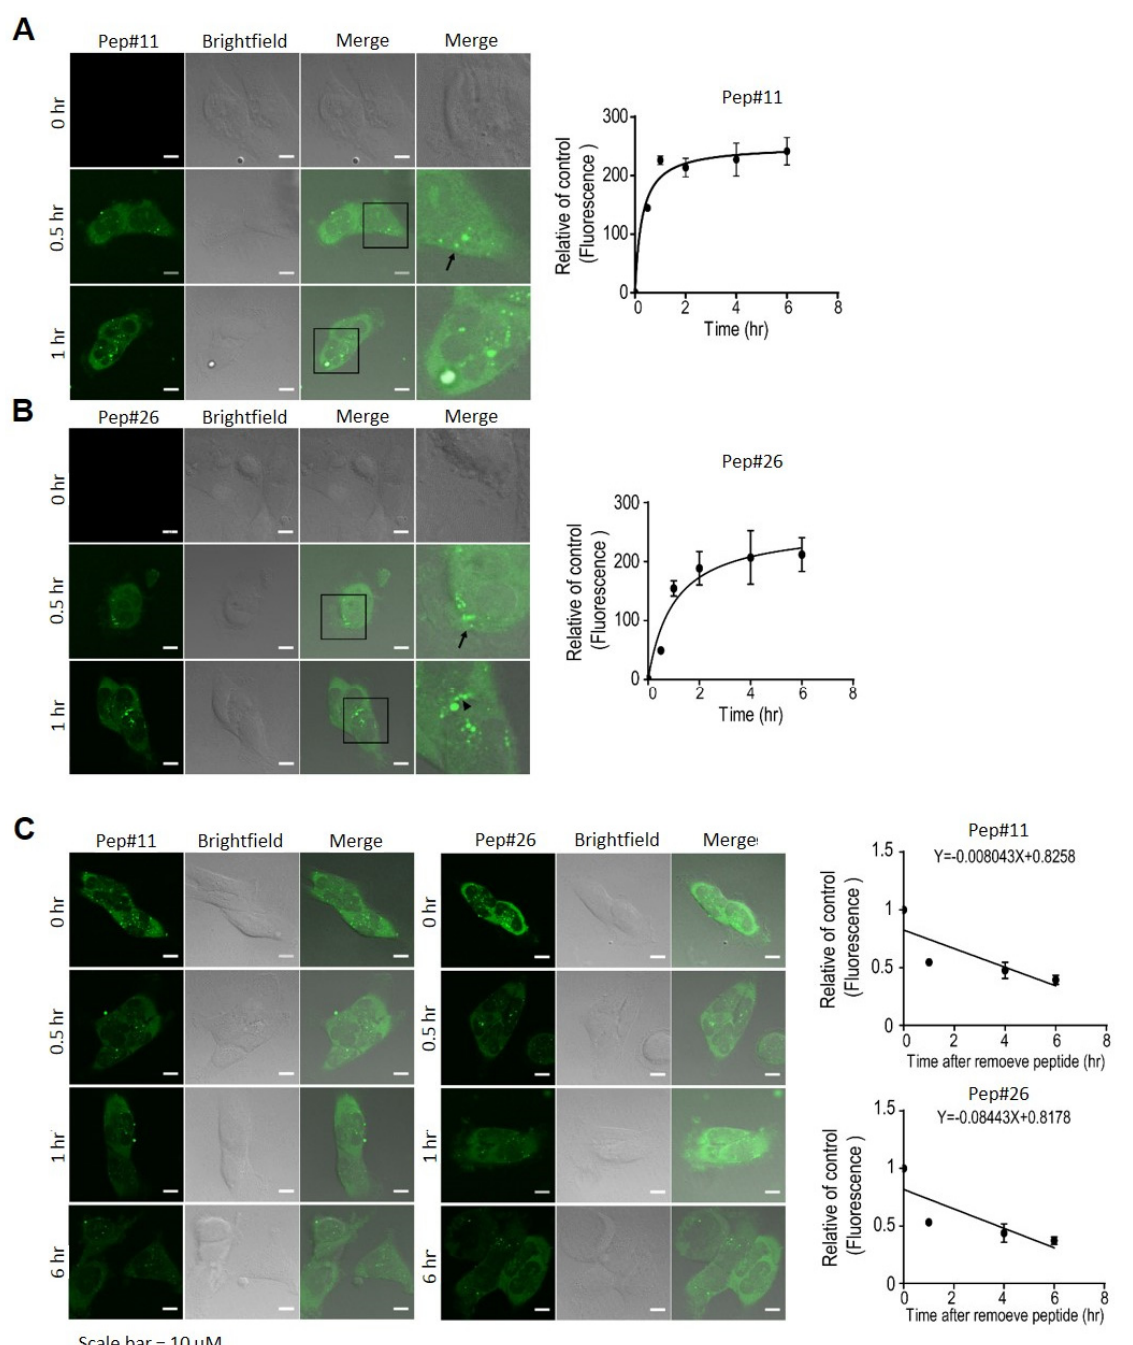
Figure 5. The subcellular localization, cellular intake, and stability of the decoy peptides. ( A , B ) DBTRG-05MG cells treated with the 5 ′ FAM-labeled decoy peptides, 5 ′ FAM-Pep#11 or 5 ′ FAM-Pep#26, were analyzed at 0, 0.5, and 1 h by confocal microscopy. Quantitative analyses were performed from fluorescent intensities detected by ELISA reader ( n = 3 at each time point). ( C ) Cells were respectively treated with two 5 ′ FAM-labeled decoy peptides for up to 6 h. Cells were observed under microscopy and fluorescent intensities were measured by ELISA reader at the indicated time points. To facilitate comparison of intake and degradation dynamics, mean fluorescence values were normalized to stating fluorescence. All data represent three independent experiments. Scale bar = 10 µ